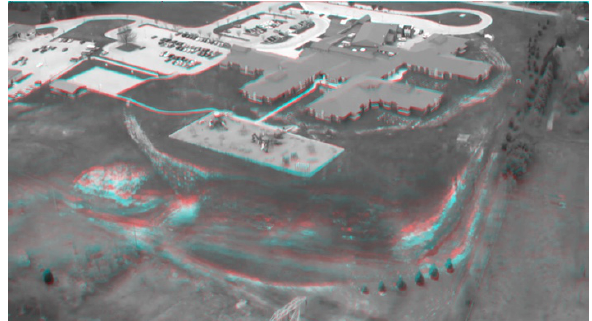
Figure 2. Example of extreme (tens of pixels) jitter distortion in images obtained from a helicopter with a handheld APS camera. Sequential frames from a video sequence have been combined in color to emphasize the changing geometric distortion.